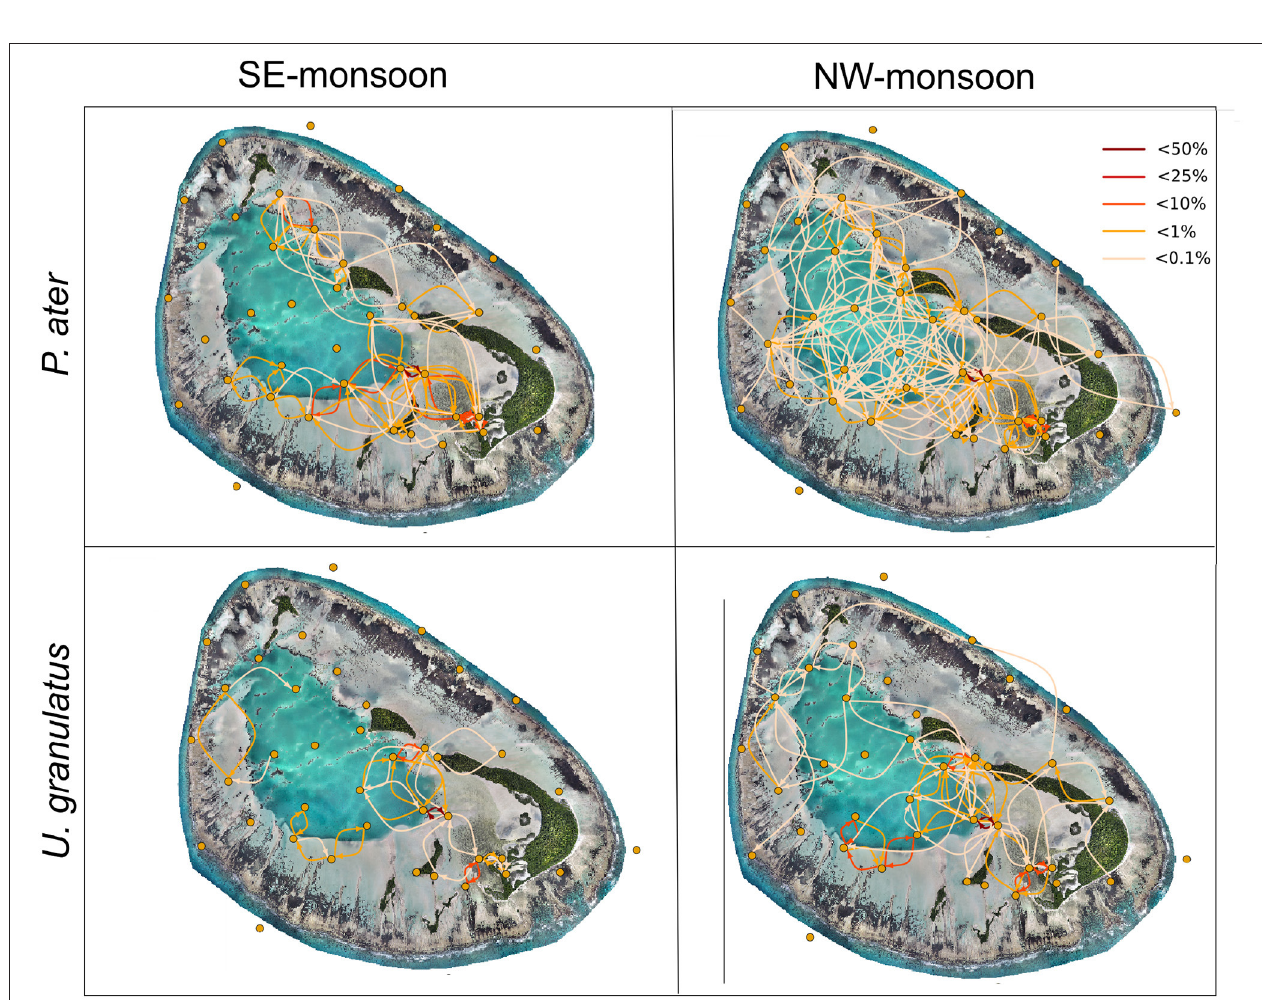
FIGURE 2 | Seasonal networks constructed for acoustically tagged stingrays (networks summed for all tagged individuals). Yellow dots represent nodes (acoustic receivers). Lines between nodes represent edges (movements between receivers). The color of the edge represents the proportions of movements between receivers. Map was produced using drone image, Copyright of Drone Adventures for the Save Our Seas Foundation.